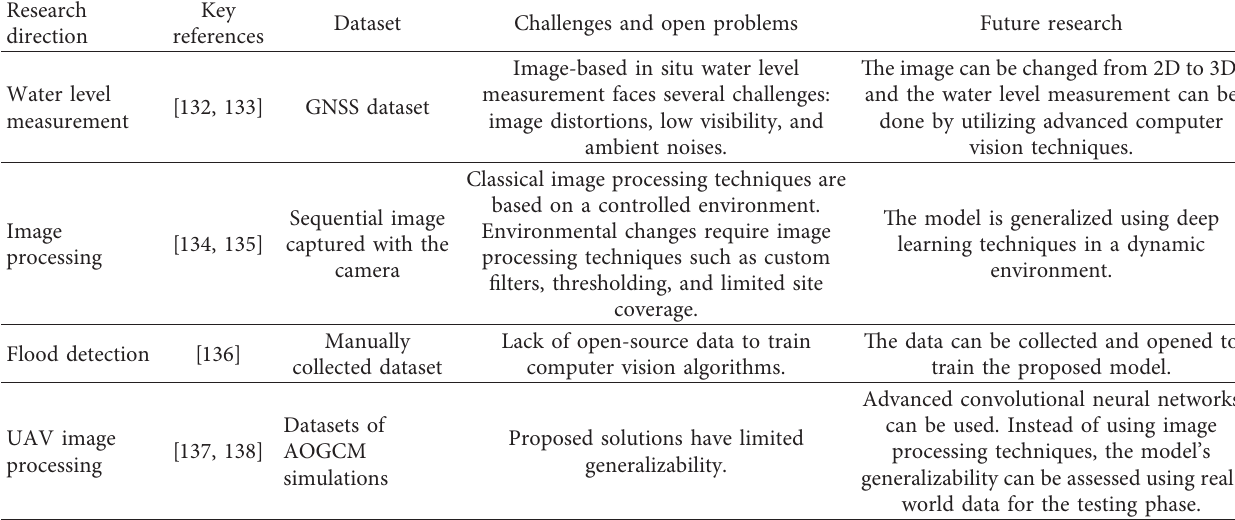
Table 8: Challenges and open problems for computational visual perception-driven image